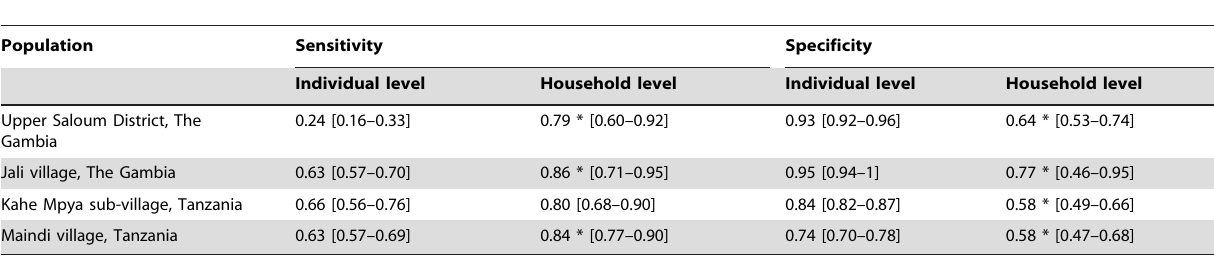
Table 1. Sensitivity and specificity of active trachoma as a marker of infection.